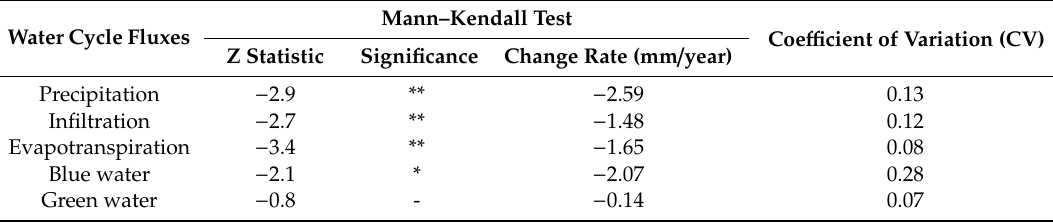
Table 7. Mann–Kendall test results and the CV values for water cycle fluxes in